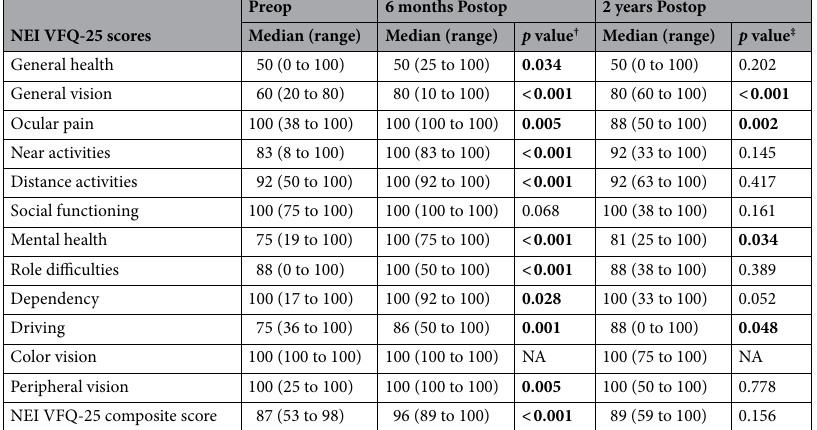
Table 2. NEI VFQ-25 composite score and scores of the 12 sub-categories, prior to surgery, at 6 months and 2 years postoperatively. SD standard deviation, NA not applicable, NEI VFQ-25 National Eye Institute